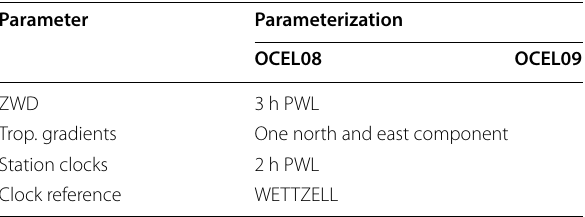
Table 2 Parameterization of the nuisance parameters, i.e., clock and troposphere